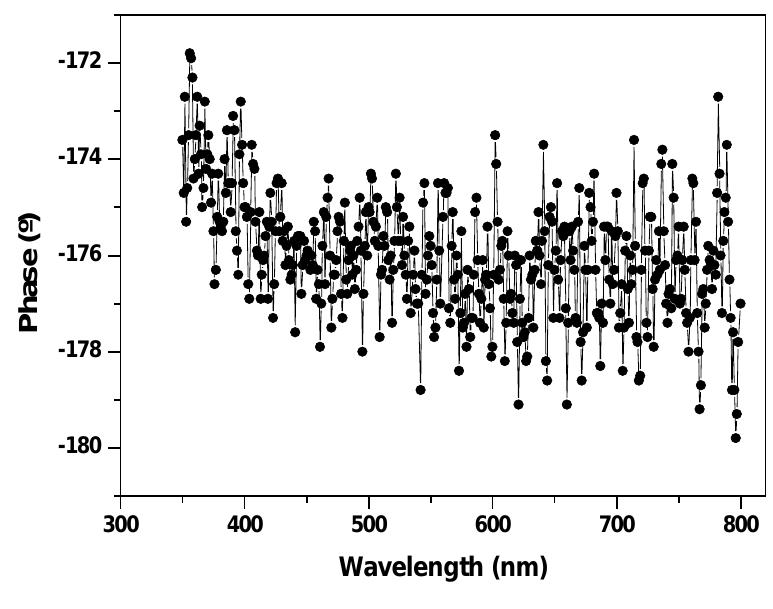
Figure 6. Reference phase of the microphone signal. It can be observed that it is almost constant, with a central value of – 176° with oscillations of about ±